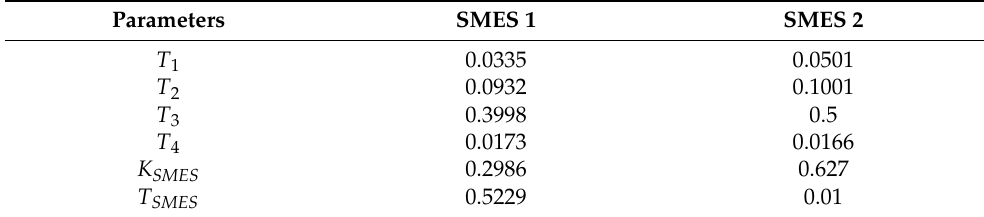
Figure 10. GCSC arrangement in the series of the transmission line.